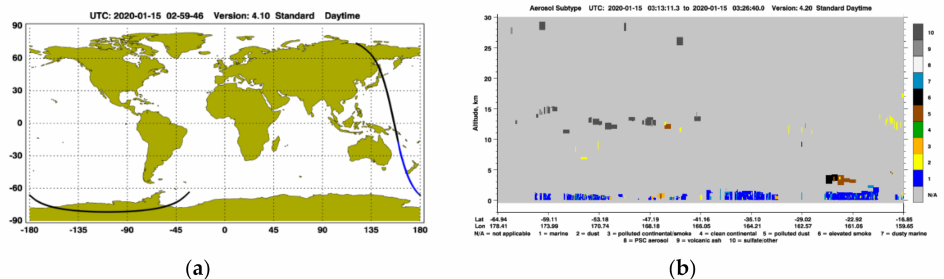
Figure A3. CALIPSO lidar’s profile of aerosols on 15 January 2020 along the CALIPSO satellite path from southern New Zealand to the Tasman Sea and the Coral Sea off Queensland ( a ) and distribution of aerosol types above the ground ( b ). Smoke aerosols (black) in the upper troposphere (10–15 km) and the stratosphere (25–30 km) over the Tasman Sea and southern New Zealand.